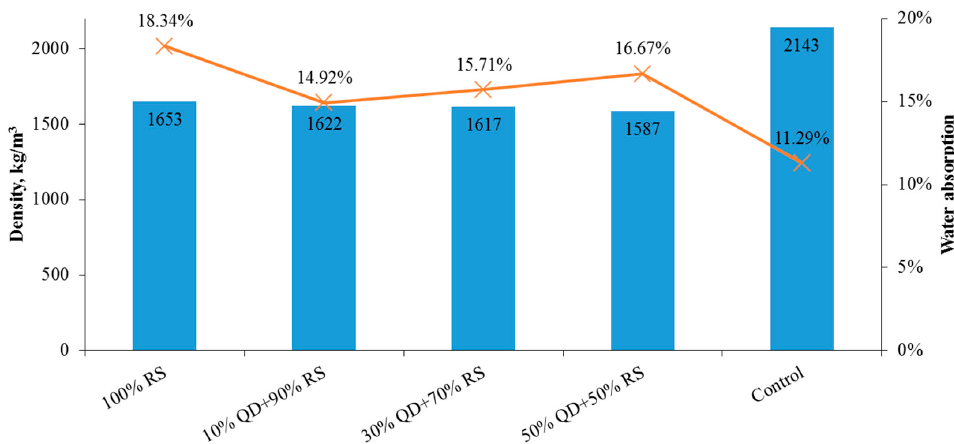
Figure 7. Water absorption of the design mix.